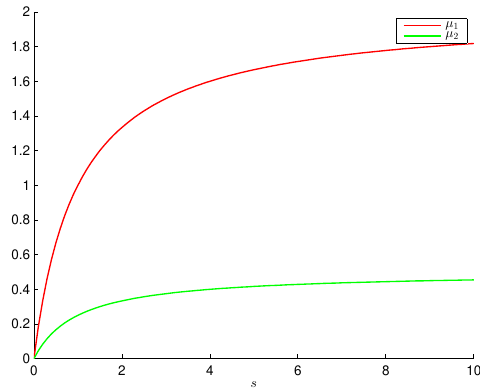
Figure 4. Kinetic growth rates of the Monod